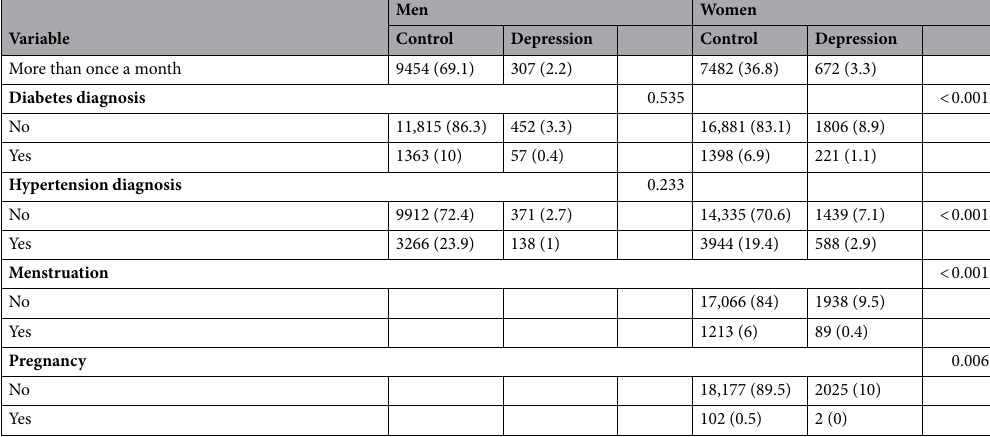
Table 1. Sociodemographic characteristics of the study sample. Continuous and categorical variables are expressed as the mean (standard deviation) and frequency (percentage). p-values were obtained from the chi- square tests for categorical variables.